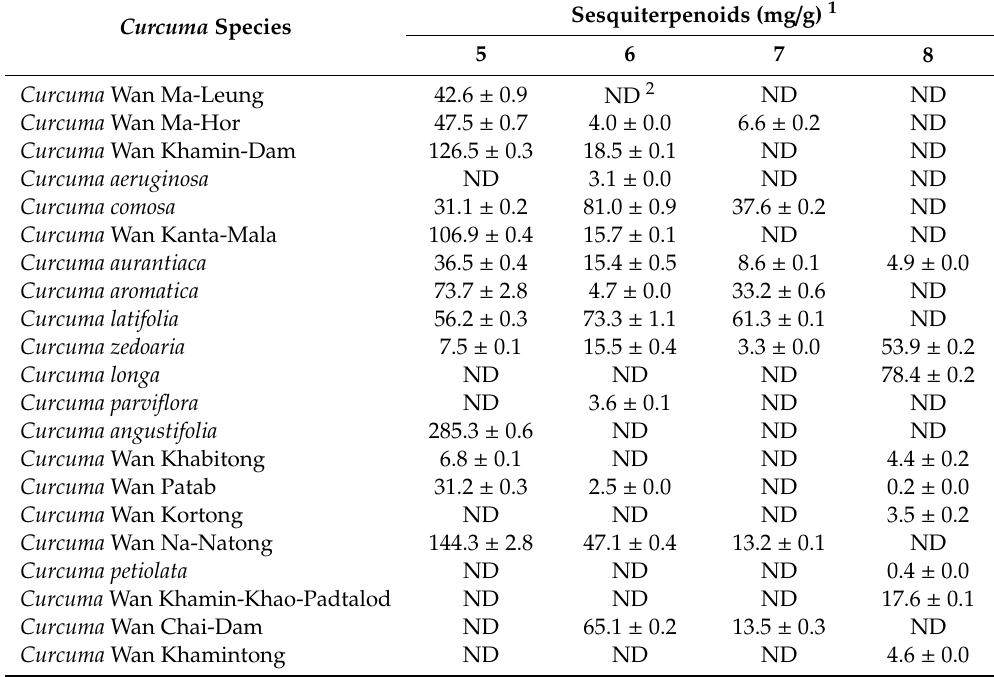
Table 4. Analysis of sesquiterpenoids from the ethanol extraction residues of Curcuma